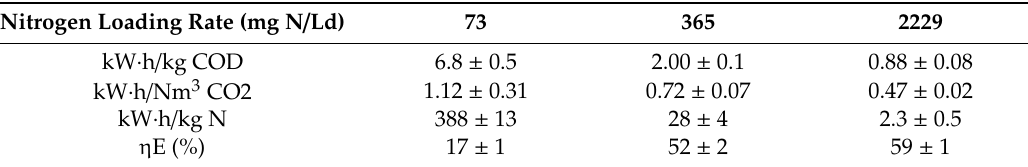
Table 4. Energy consumptions for the di ff erent MEC operations and energy e ffi ciencies of the MEC during the three operating